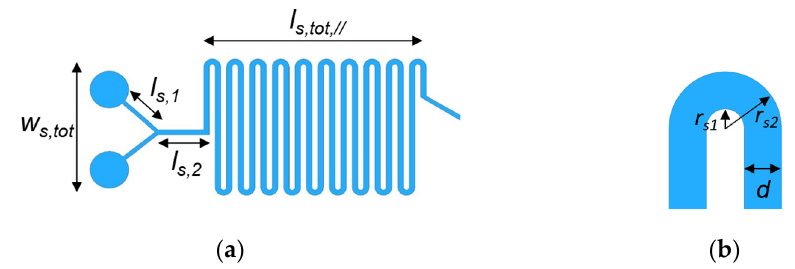
Figure 2. ( a ) Micromixer based on PDMS serpentine channel; ( b ) Zoom of the bent region. Table 2. Micromixer geometrical parameters Parameter Value [µm] Channel width ( d ) Total length of mixer ( l s,tot// )